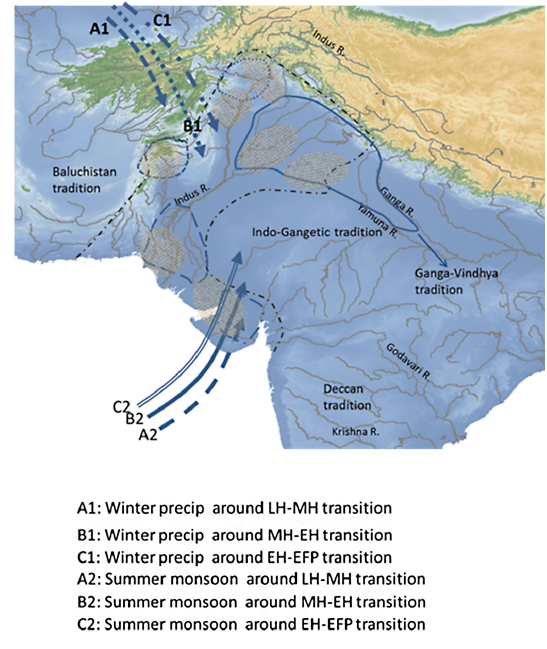
Fig. 8. The role of the strengths of the rains on the rise and the dispersal of the Indus Tradition. The lengths of the arrows indicate the magnitude of the rains. The directions of the arrows coarsely describe the flow of moisture. The hatched areas represent Early Harappan settlements and the smaller enclosed shapes are the ex- tents of Late Harappan settlements. The extent of the Mature Harap- pan Era is represented by the dashed